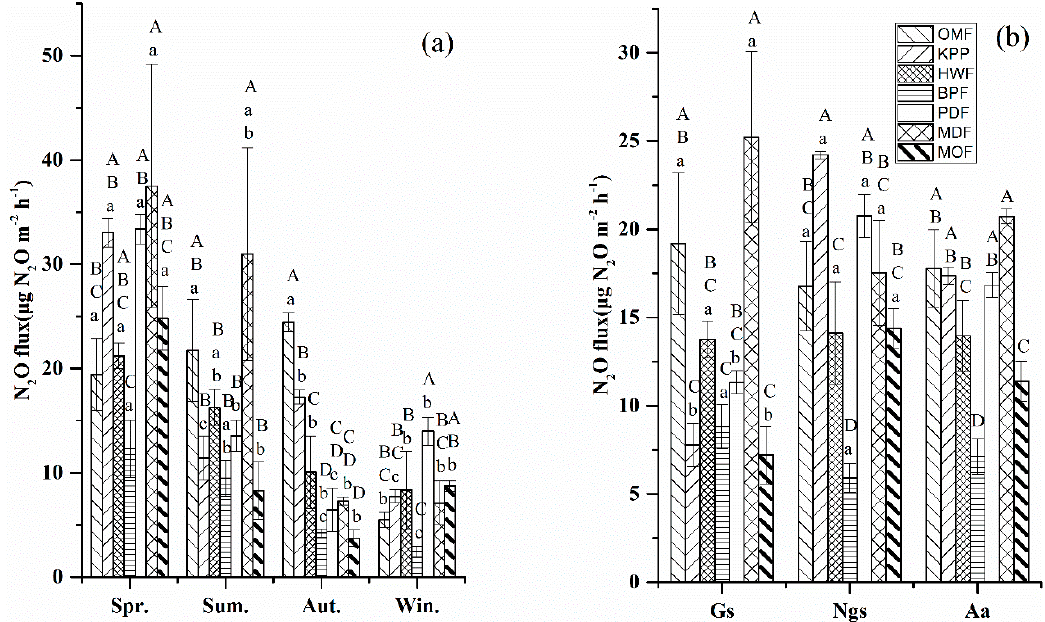
Figure 5. Seasonal variations ( a ), dynamics of Gs and Ngs ( b ), and the annual average ( b ) of nitrous oxide emissions from the over-mature forest, Korean pine plantation, and five secondary forests at the Maoershan Ecosystem Research Station in Northeast China. See Figure 2 for the explanation of the di ff erent lowercase letters and capital letters and the di ff erent